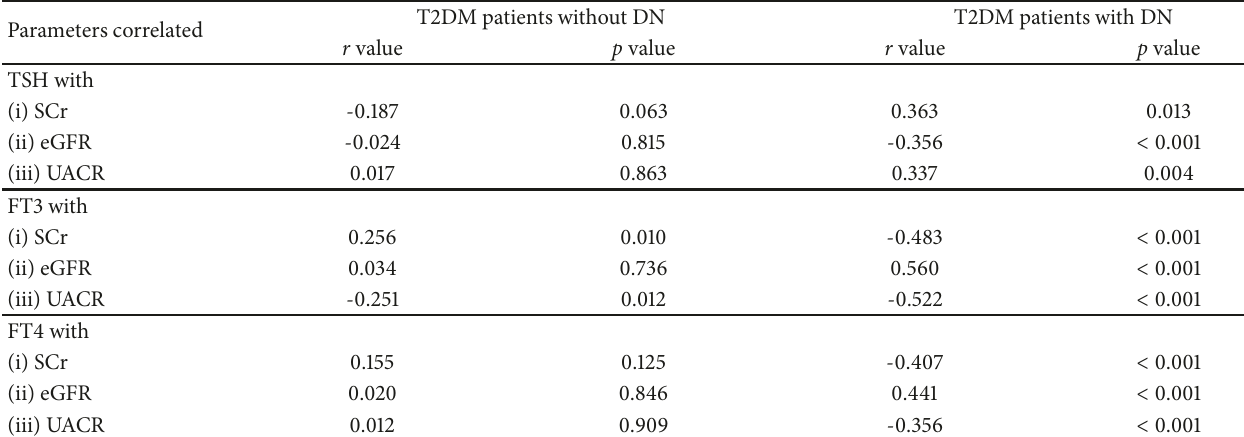
Table 3: Correlations between thyroid function and related renal indexes in T2DM patients without and with DN. Parameters